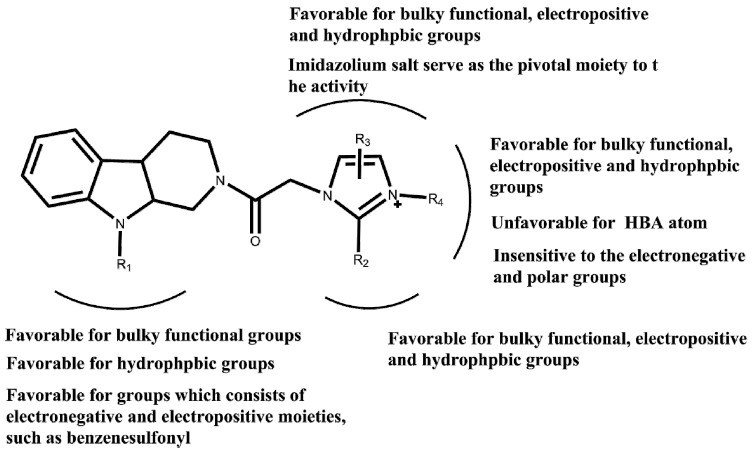
Figure 10. Important structural requirements of benzoxazepine moieties by means of the ligand based 3D-QSAR and structure based molecular docking study.